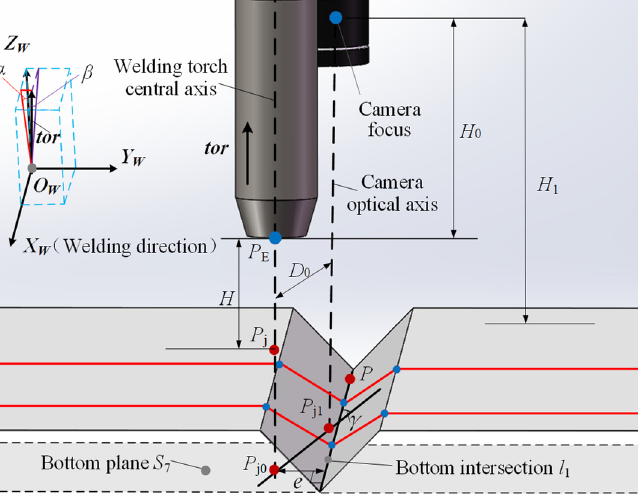
Figure 9. SPP of welding torch relative to welding groove.